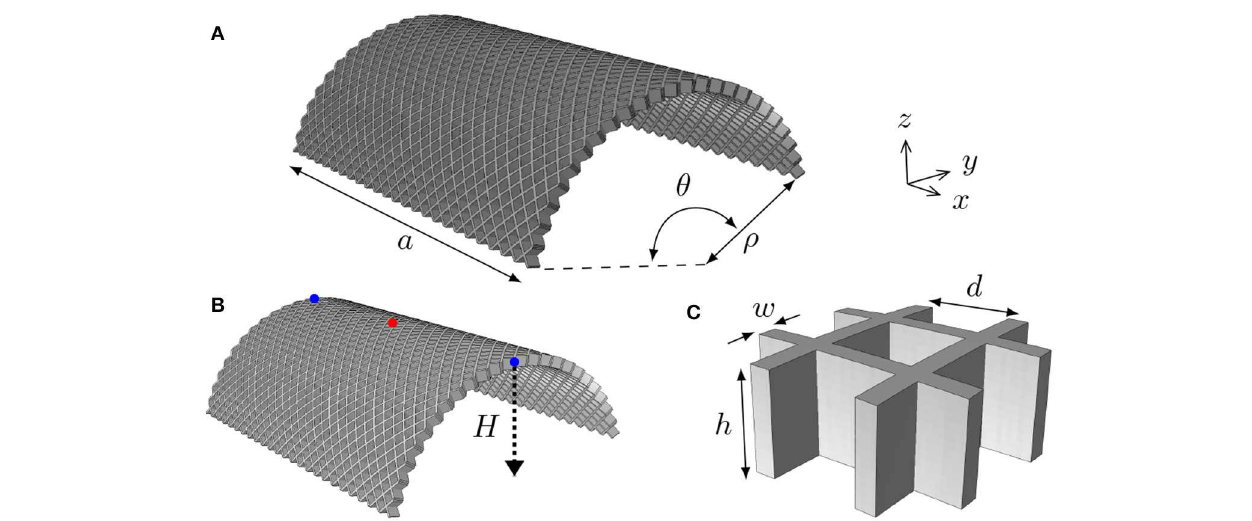
FIGURE 1 | The relevant global (A) and local (C) dimensions are shown. Unless otherwise indicated, we are only concerned with square shells i.e., the arclength along the curved direction is equal to a . In (B) , a diagram of the initial shell geometry is shown, indicating how the model is actuated. Throughout the simulation, the center nodes (red) are fixed, while the nodes shown in blue are moved in the negative Z direction. geometry, D 11 D 22 . Hence, for simplicity, we use D 11 = D 1 and D 66 D 6 . For arbitrary ligament sections, these are =